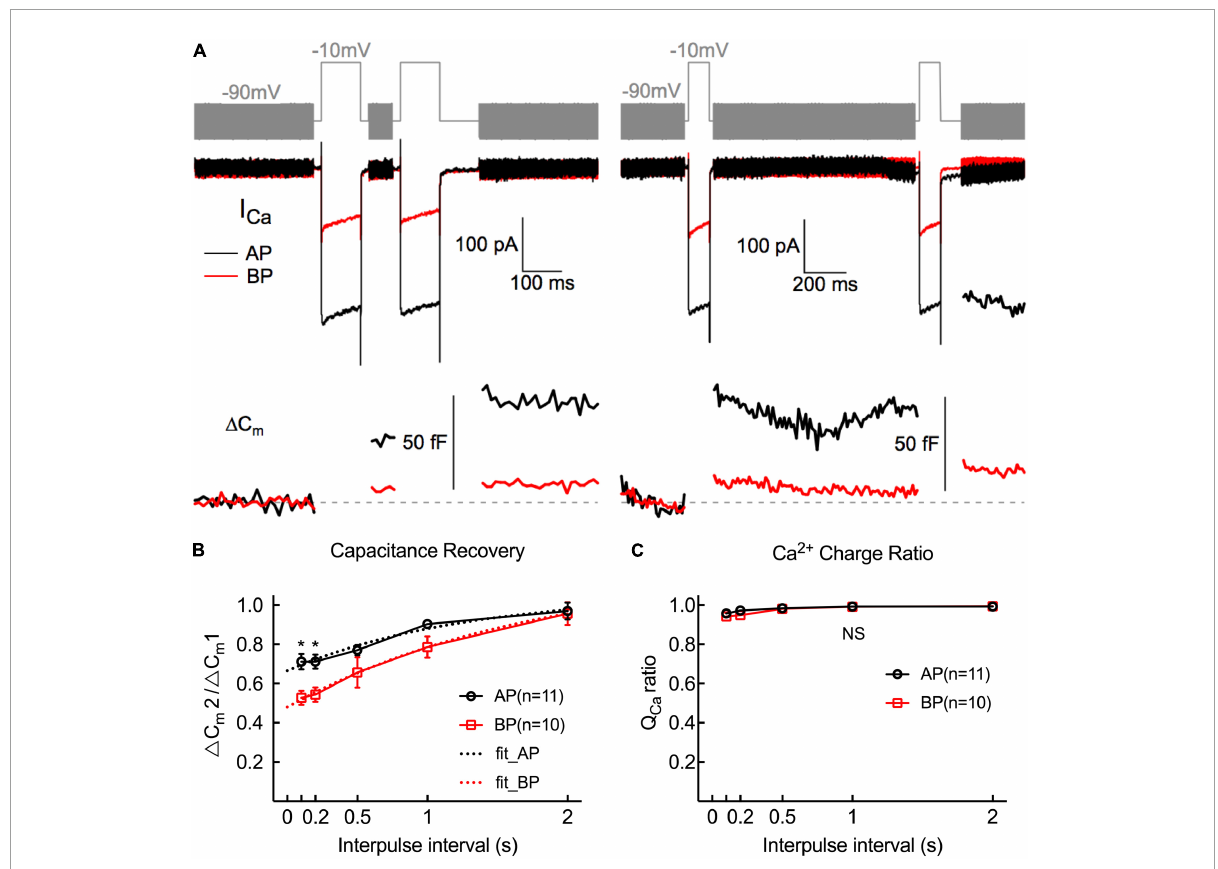
FIGURE6 Replenishment of synaptic vesicles from hair cells Paired pulses (depolarized to –10 mV lasting 100 ms) with variable intervals (from 100 ms to 2 s) between both stimuli were used to measure the time course of endocytosis in AP and BP hair cells ( n = 11 and 10). (A) Two paradigms of C m traces and Ca 2 + current responses with intervals of 100 ms (left) and 1 s (right). The double pulses induced notable I Ca and (cid:49) C m . (B) The fraction of the (cid:49) C m increment ( (cid:49) C m2 / (cid:49) C m1 ) elicited by the first and second depolarizations at certain intervals was calculated to quantify the synaptic vesicle replenishment. Synaptic vesicle replenishment was significantly faster in AP than in BP hair cells at intervals of 100 ms and 200 ms. * means p < 0.05. (C) The ratio of Ca 2 + charge in two stimulation durations showed no significant difference in both cell types.